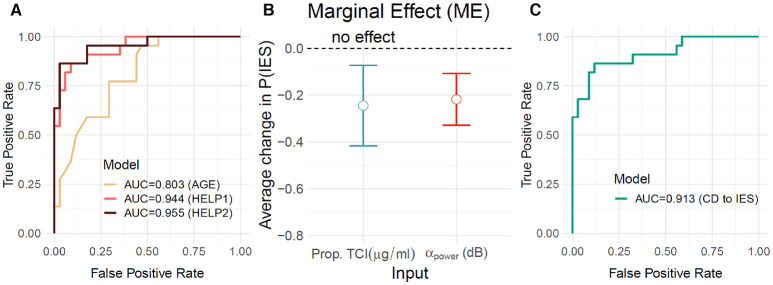
Generalization testing on burst suppression data. To probe the generalization of the proposed model beyond the given sample we considered the observational data from Touchard et al. (2019) in which burst suppression was studied as a proxy for cognitive decline. The dataset comprised 56 patients sedated with Propofol. None of these patients was included in the previous analyses. In a first step (A), we applied the models as defined in the previous analyses (Figures 1, 2) to predict the occurrence of IES during the induction period. HELP1 (TCI + ABP) predicted IES (AUC=0.94, orange) better than AGE (AUC=0.80, yellow). Prediction did not increase significantly for HELP2 (TCI + ABP + Age) as compared to HELP1. We then inspected the HELP1 (IES) model (B). As in previous analyses, TCI (blue) and ABP (red) showed complementary average marginal effects (mean±SE: −0.25±0.09, −0.22±0.06 for TCI and ABP, respectively). We then directly quantified generalization performance (C) of the HELP1 (CD) on the IES dataset (AUC=0.91). The results suggest that the proposed HELP model generalizes beyond the observed sample and captures cognitive and physiological factors related to postoperative outcome.